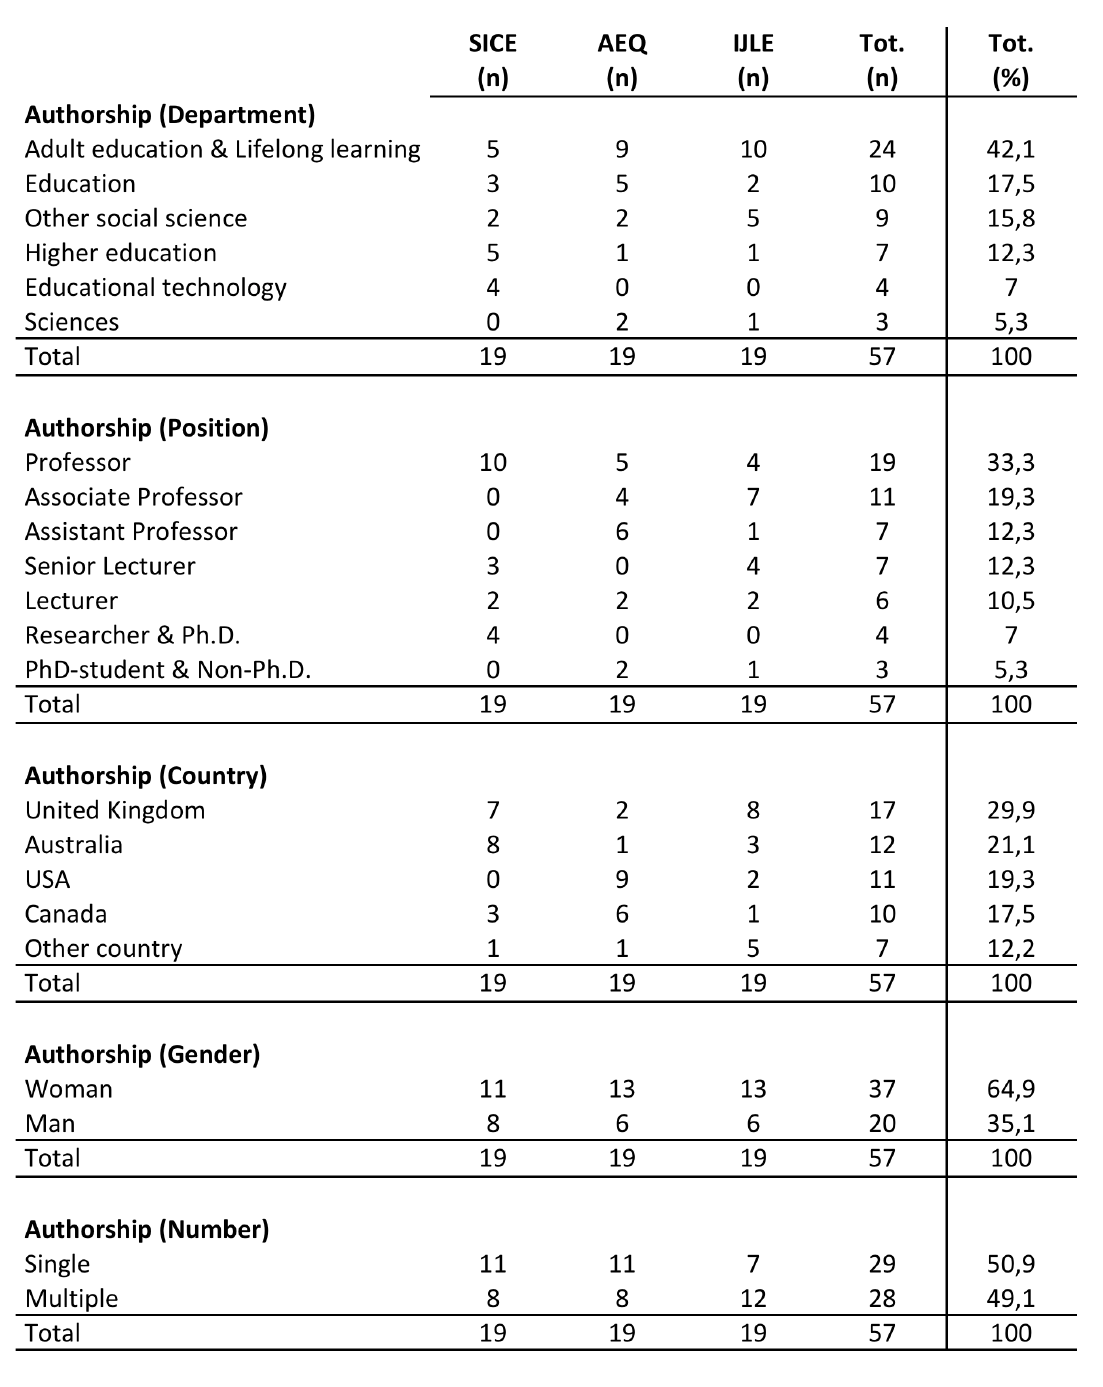
Table 3. Number and share of top-cited articles in three adult education journals, categories related to